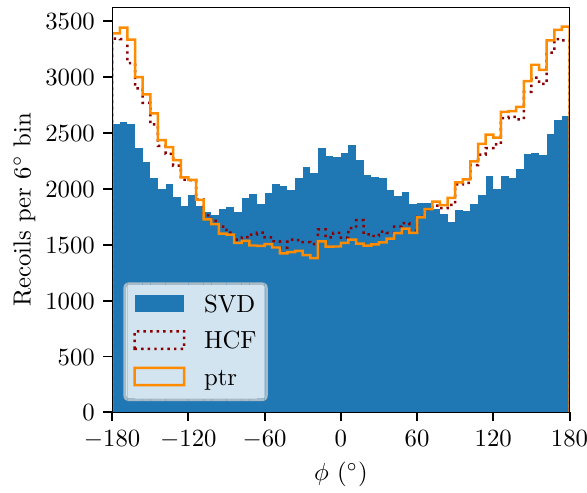
Fig. 21 Histograms of φ from the SVD prefit (solid blue) and after flipping according to HCF (dotted line) and ptr (solid line) using the beam-on dataset and alpha recoil candidates identified by the selection shown in Fig. 20(bottom). The beam pipe is located at φ = ± 180 ◦ , and the peak in the prefit distribution at φ = 0 ◦ is presumably due to head-tail swaps. With ptr , we see a complete reassignment of these swapped tracks to the correct peak